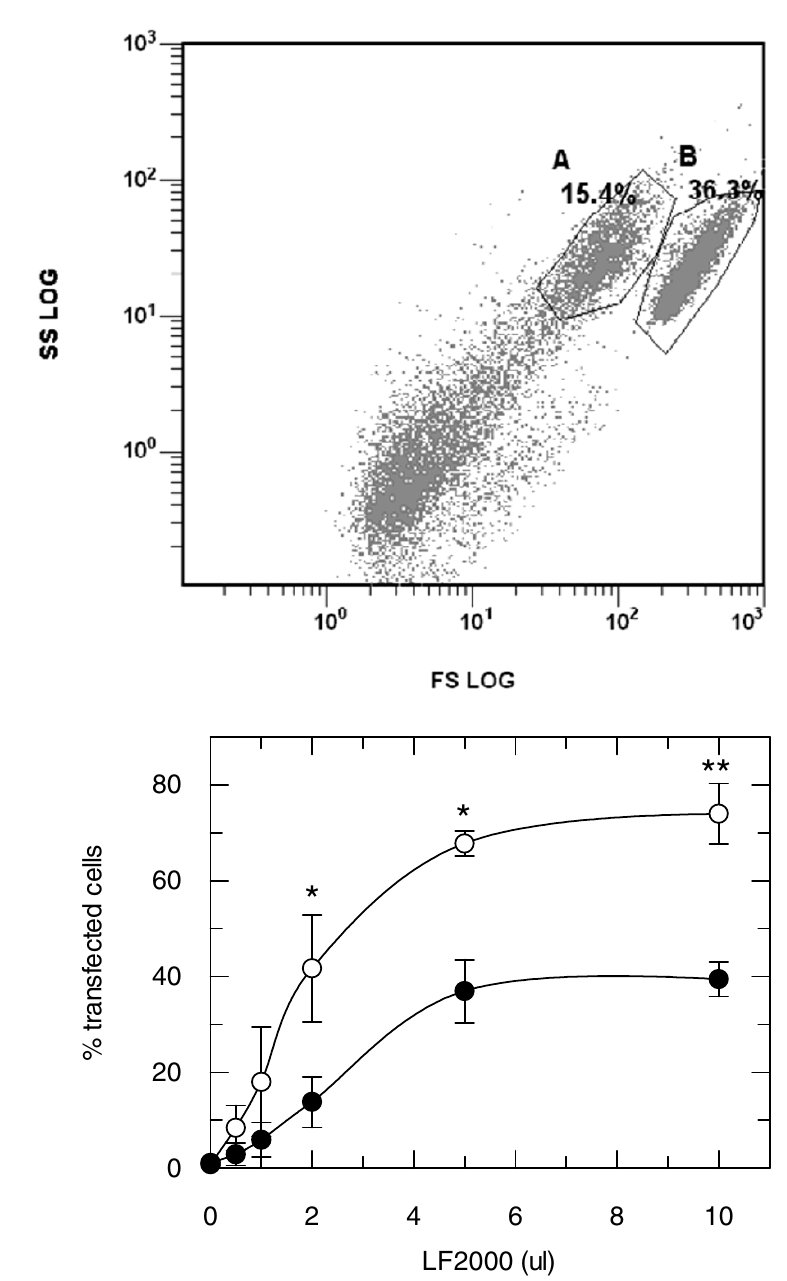
Figure 4 Quantification of the rates of transfection efficiency in the presence of increasing concentrations of LF2000. Upper panel: Flow cytometric analysis showing forward scatter against side scatter of Cho.hIR cells transfected with pGREEN LANTERN using 10 µ l LF2000 reagent (ratio of LF2000 to cDNA of 1.1). The separation of intact cells into two subpopulations is indicated by the gates. Percentage values show the relative proportions of the two cell populations compared to the total number of events measured. Lower panel: The proportion of transfected cells in each subpopulation of Cho.hIR cells plotted against the volume of LF2000 reagent used. Data are the average ± S.D. from three experiments which were performed in duplicate for each LF2000 concentration. Filled circles, population A, open circles, population B. *p < 0.01 transfection rate in A> B; **p < 0.001 transfection rate in A >